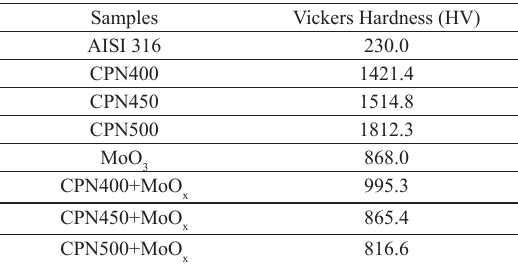
Table 4. Surface microhardness values of AISI 316 stainless steel after plasma nitriding and MoO deposition. 3